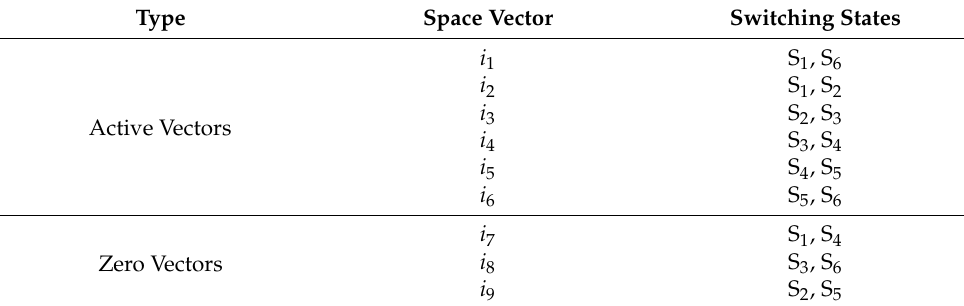
Table 1. Switching states and space vectors of CSC.